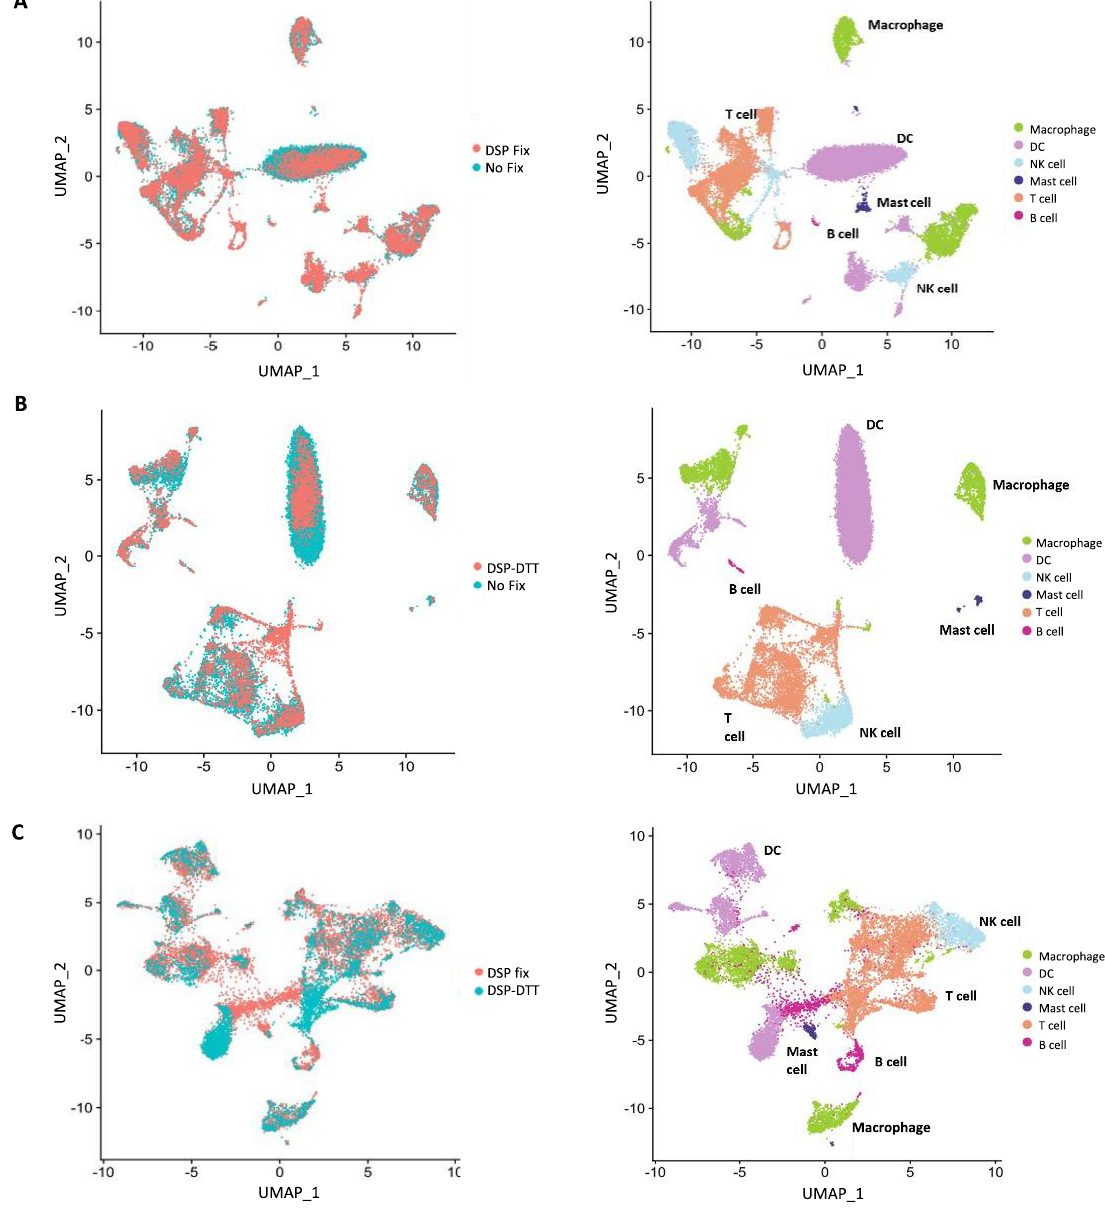
Figure 6. Uniform manifold approximation and projections. Representation (from left to right) of an overlay of cell dispersion, clustering, and cell type annotation for the analyzed samples: unfixed cells compared to DSP-fixed cells ( A ), unfixed cells compared to DSP-fixed/DTT de-crosslinked cells ( B ), and DSP-fixed cells compared to DSP-fixed/DTT de-crosslinked cells ( C ).